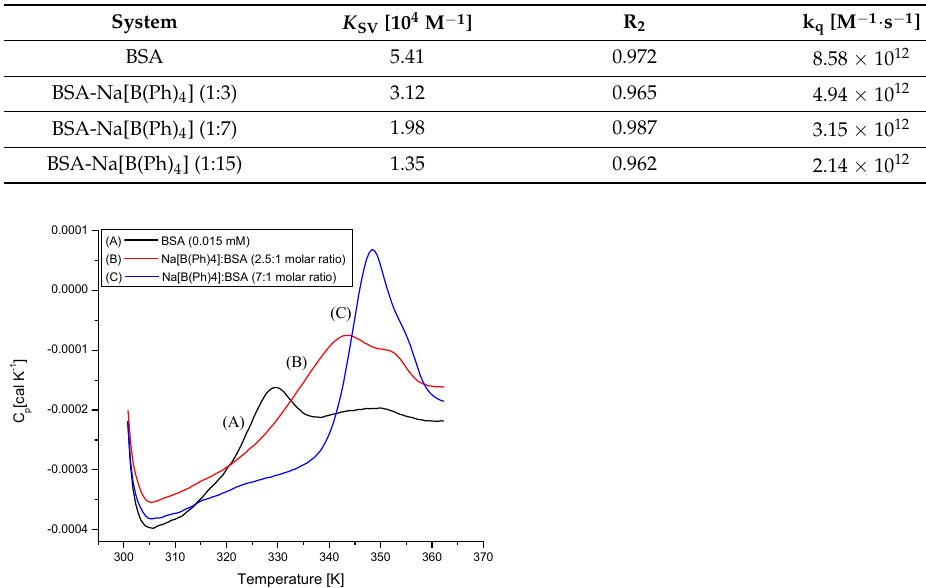
Figure 7. The raw heat capacity data for: (A) free BSA (0.015 mM) and the mixtures (B) with the Na[B(Ph) 4 ]:BSA molar ratios 2.5:1 (0.0375 mM Na[B(Ph) 4 ], 0.015 mM BSA) and (C) 7:1 (0.105 mM Na[B(Ph) 4 ], 0.015 mM BSA) in the 10 mM Caco buffer of pH 7.